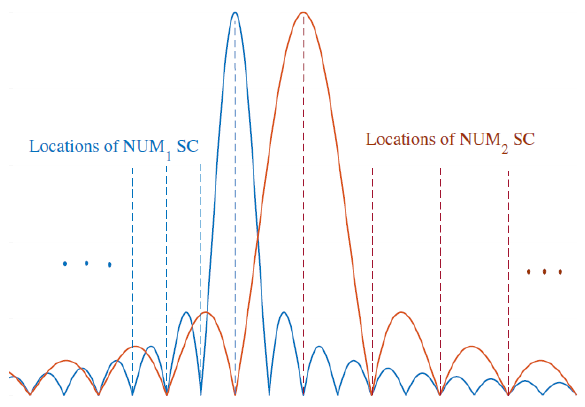
Fig. 2. Multiplexed subcarriers of two numerologies [7]